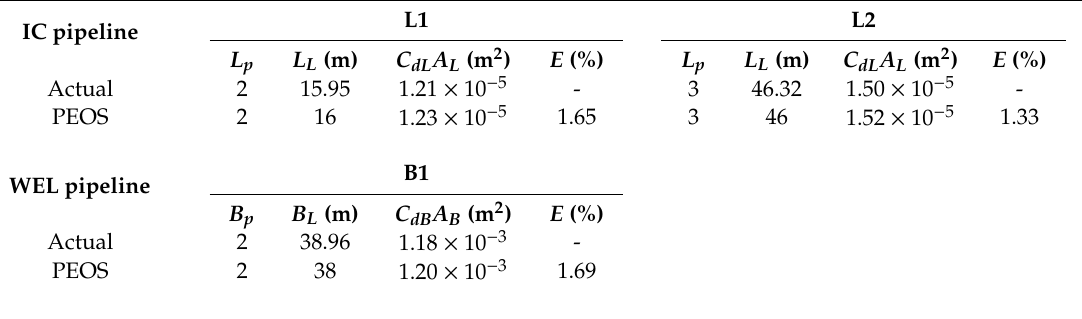
Figure 2. The simulated head distributions at the valve for ( a ) the Imperial College (IC) pipeline and ( b ) the Water Engineering Laboratory (WEL) pipeline. Table 3. The predicted and actual fault information for the two pipeline systems.